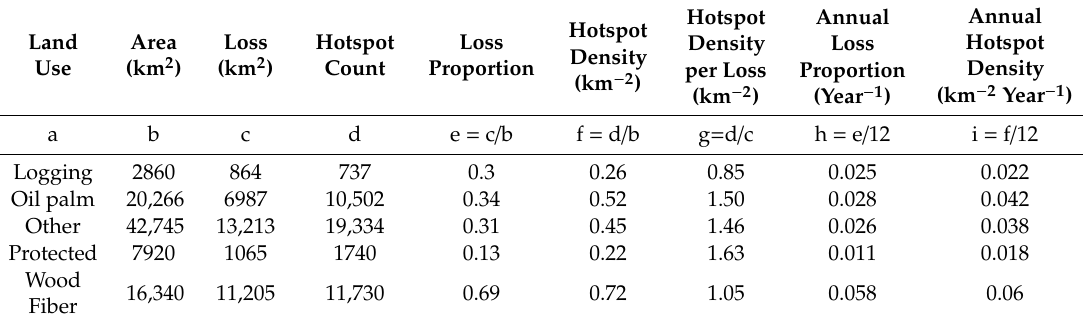
Table 3. Annual forest loss and hotspot density as a function of